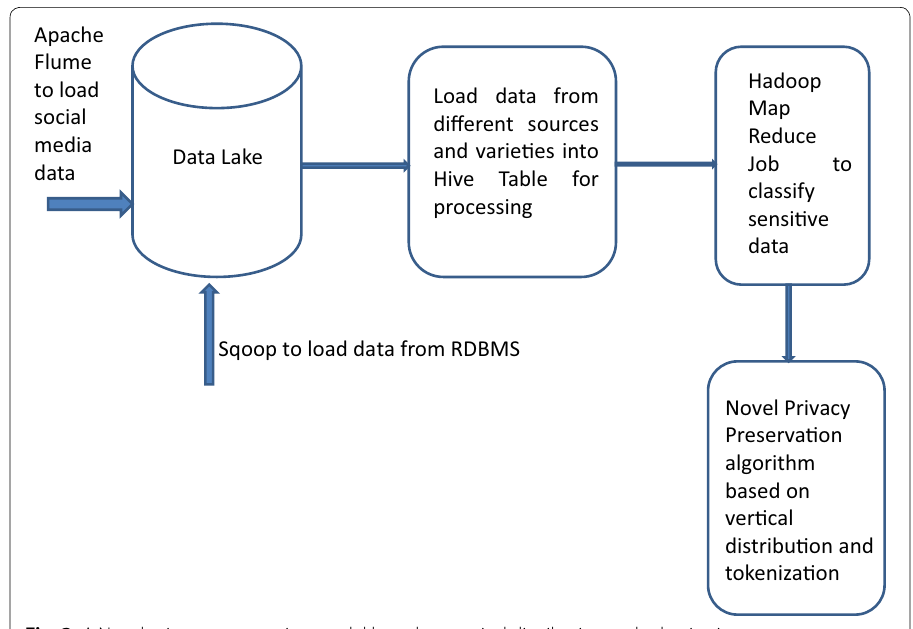
Fig. 3 A Novel privacy preservation model based on vertical distribution and